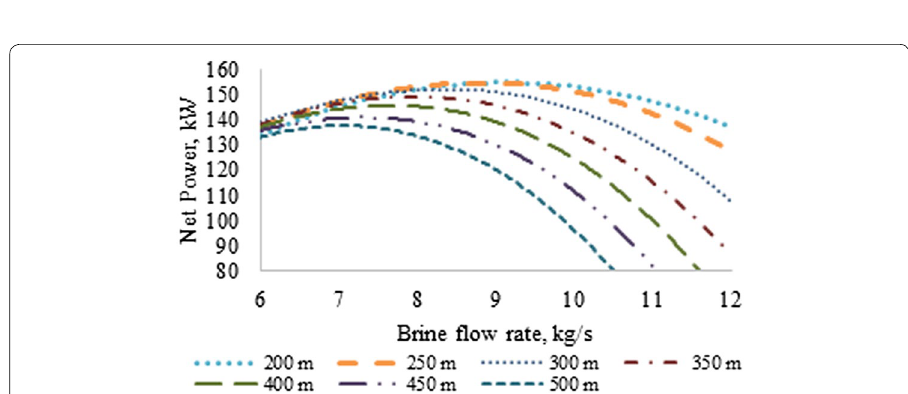
Fig. 14 Net power development for the fully perforated well case